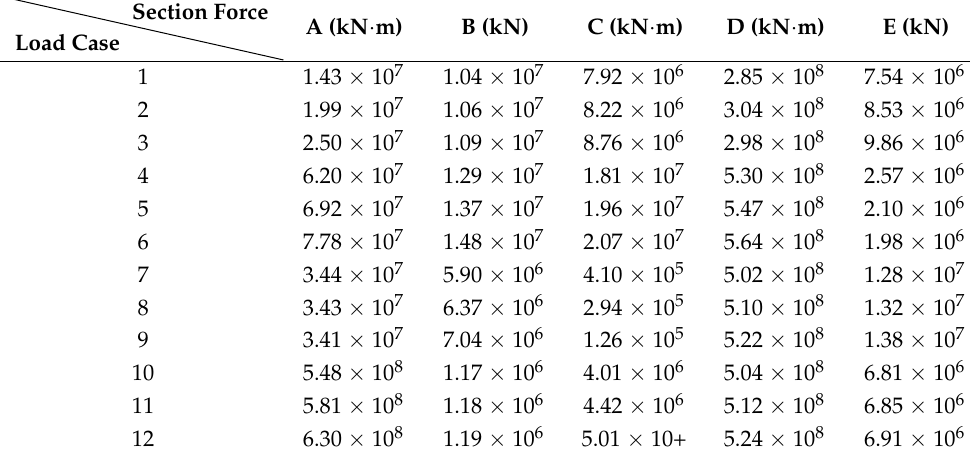
Table 7. Calculation results of the internal force of the control section of the local connection node of the object platform.